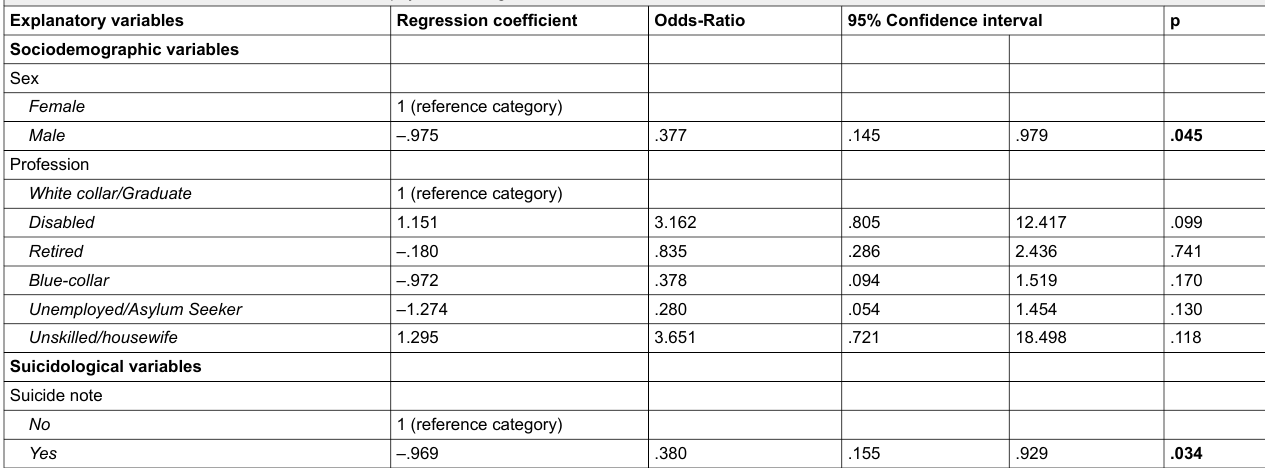
Table 4: Predictors of suicides without established psychiatric